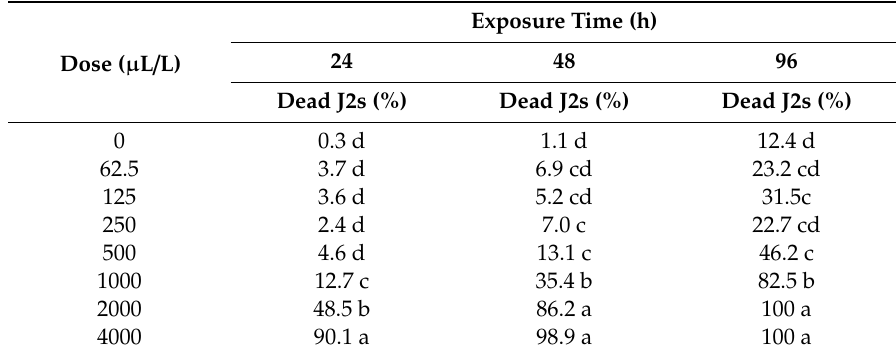
Table 3. E ff ect of essential oil on the motility of M. javanica J2s after immersion in test solutions at the doses of 0, 62.5, 125, 250, 500, 1000, 2000 and 4000 µ L / L for 24, 48 and 96 h.